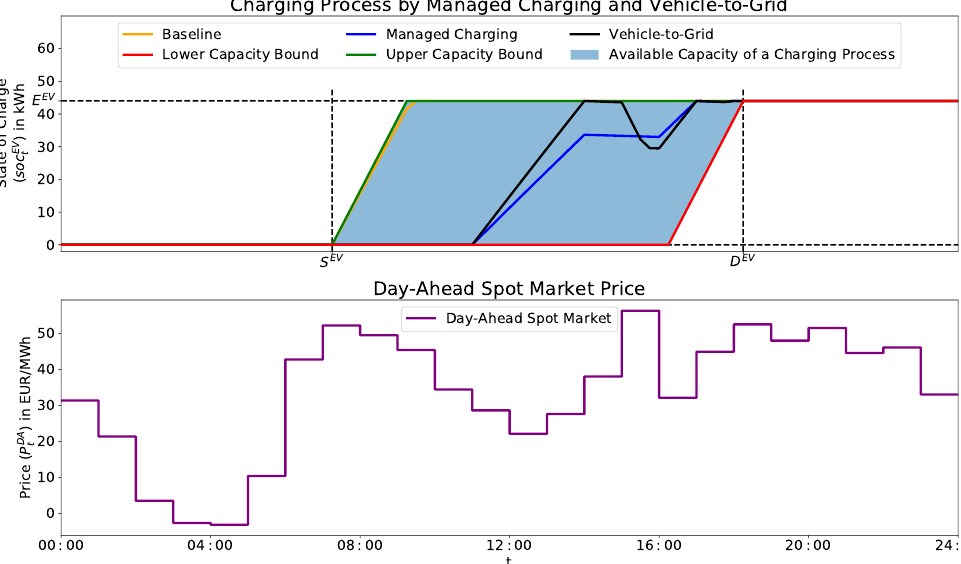
Figure 3. Charging processes of an electric vehicle by managed charging and vehicle-to-grid compared with the baseline.